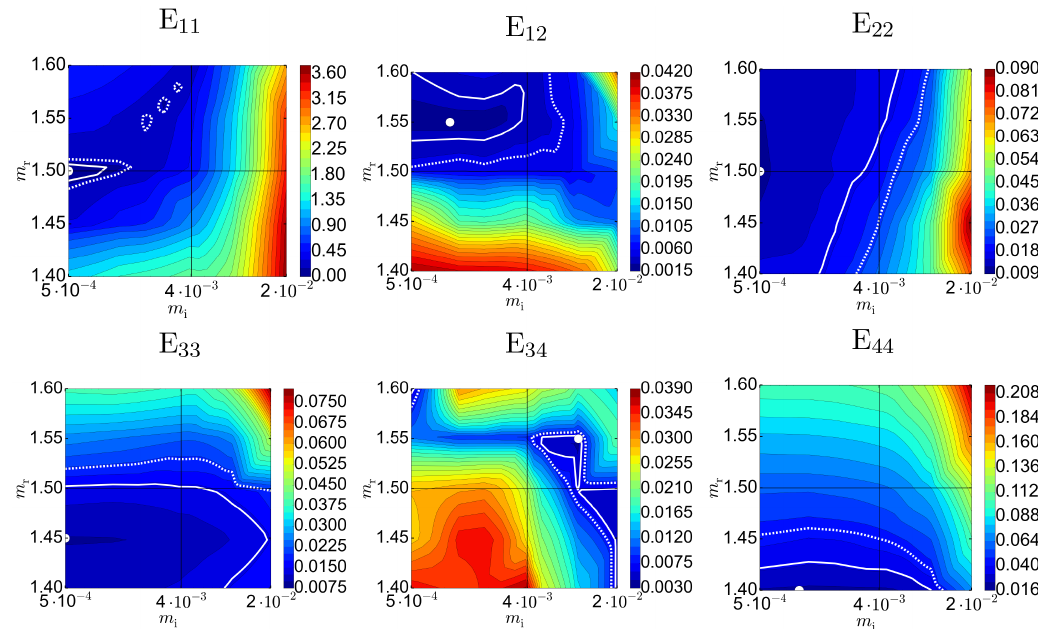
Figure 3. Scattering error E ij for different scattering matrix elements for the particle ensemble of Cal, Dol and Agg, when the ellipsoid shape weights are treated as free parameters to be fitted. Shading corresponds to different absolute errors, as described by the color bar, whereas white contour lines describe relative errors that are 150% (inner solid line) and 200% (outer dashed line) of the minimum error. The white circle marks the refractive index for which the minimum error was found, and the black horizontal and vertical lines mark the reference real and imaginary refractive index.